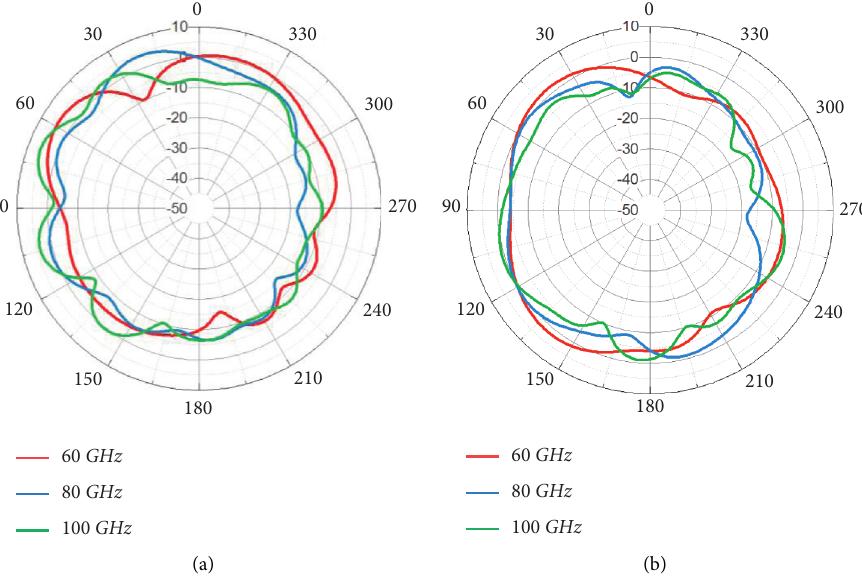
Figure 4: Polar plot radiation patterns of different planes: (a) XY-plane and (b) YZ-plane.